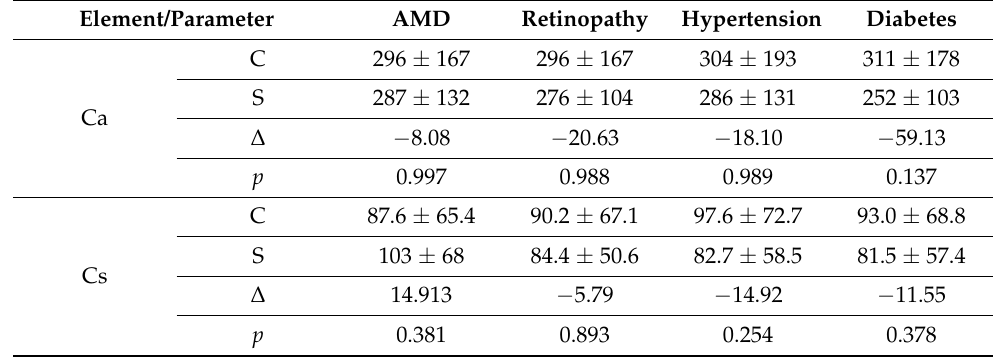
Table 1. Elemental mean concentrations (mg L − 1 ) together with the standard deviations ( ± SD), p —probability level, ∆ —blank corrected values of AH of studied patients’ groups: c—control group, s—studied